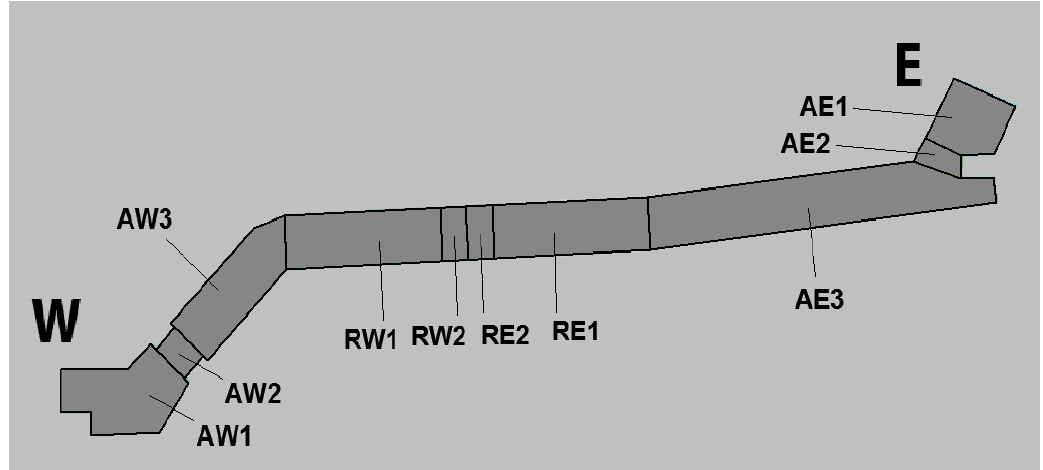
Figure 6. Subdivision of areas and ramps by direction and relative to the Mostar bridge.